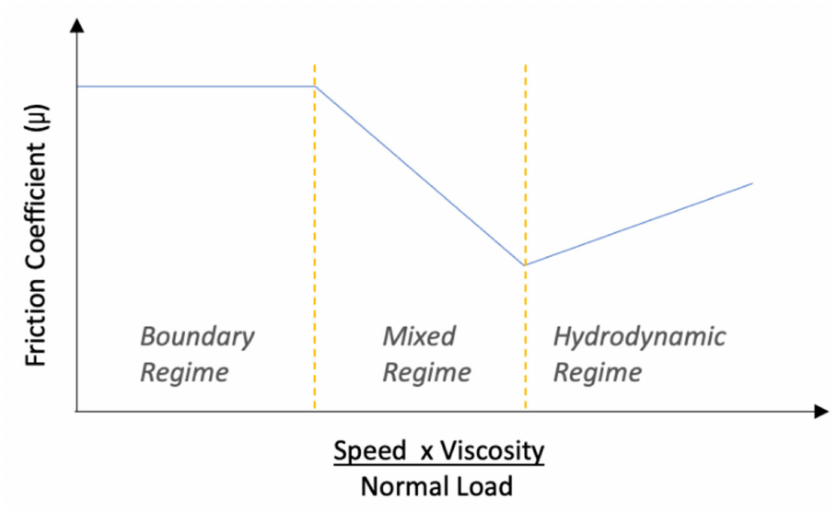
Figure 12. Stribeck